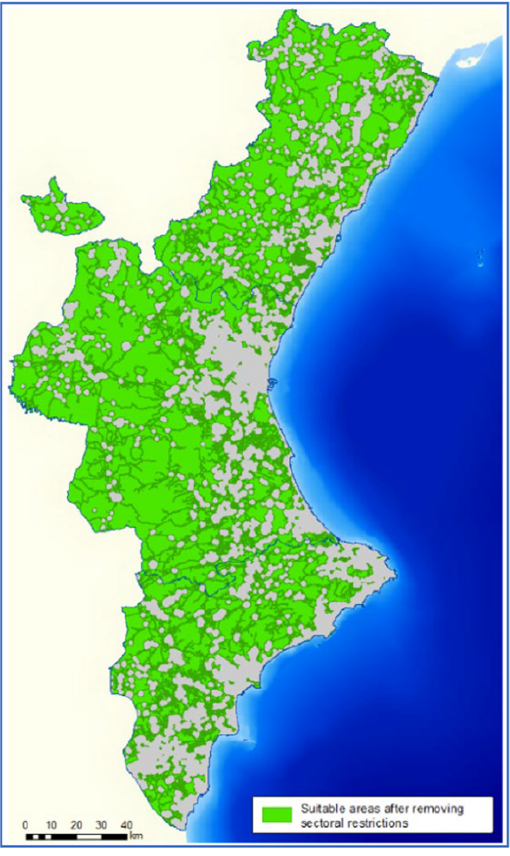
Figure 7. Suitable areas for siting pig farms in the VC in STEP 1.